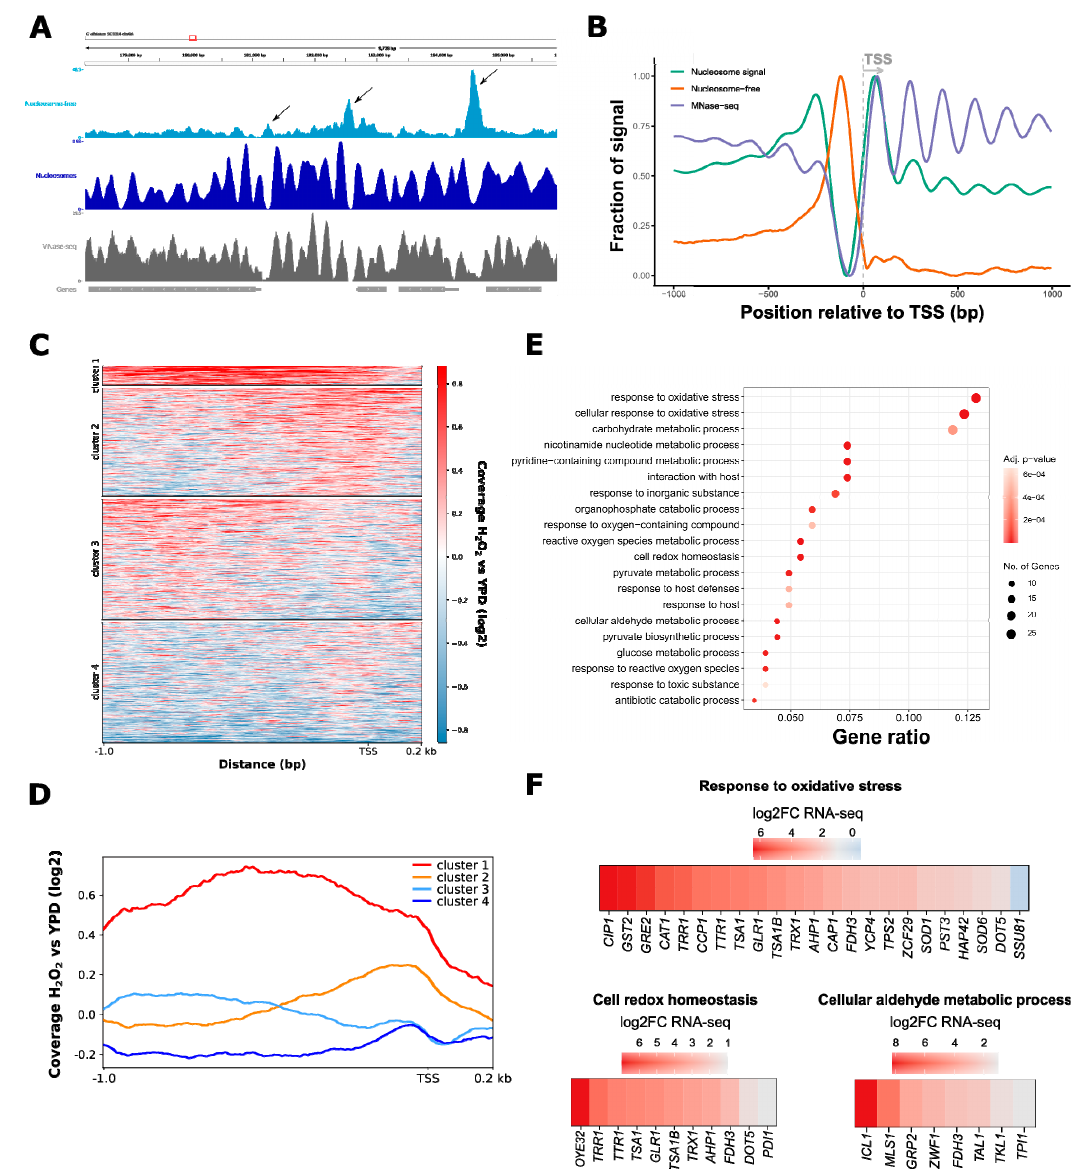
Figure 2. Chromatin accessibility is increased at promoters associated with oxidative stress genes. ( A , B ) ATAC-seq analysis in C. albicans allows for nucleosomal occupancy prediction. Comparison of coverage profiles of nucleosome-free ATAC-seq read signals with mono-nucleosomal position prediction and MNase-seq data [55] at a region on chromosome 6 ( A ) or across all C. albicans transcriptional start sites ( +/ − 1000 bp relative to the transcription start site (TSS)) ( B ). Data represent ATAC-seq samples from YPD grown cells and pooled biological replicates (see Materials and Methods for details). In panel A, genes are depicted as gray boxes with white arrows indicating the direction of transcription. The black arrows in the top IGV track indicate nucleosome-free ATAC-seq signals flanked by nucleosomes. ( C , D ) K -means clustering of di ff erential ATAC-seq nucleosome-free read coverage (log2-fold change) of H 2 O 2 -treated (H 2 O 2 ) vs. non-treated (YPD) cells represented as heat maps ( C ) or read coverage profiles across all C. albicans promoters ( − 1000 bp /+ 200 bp relative to the TSS). ( E , F ) Gene ontology (GO) term analysis of cluster 1 from panel C and D represented as a dot plot ( E ) and heat maps ( F ). Genomic regions represented in cluster 1 were annotated to the next downstream gene. The gene ratio indicates the proportion of genes enriched in this GO term relative to input genes. The color scale indicates the adjusted p -value of the GO enrichment analysis. Heat maps show genes from the indicated GO term category with the color scale representing the log2-fold change in transcription (from RNA-seq data) in response to oxidative